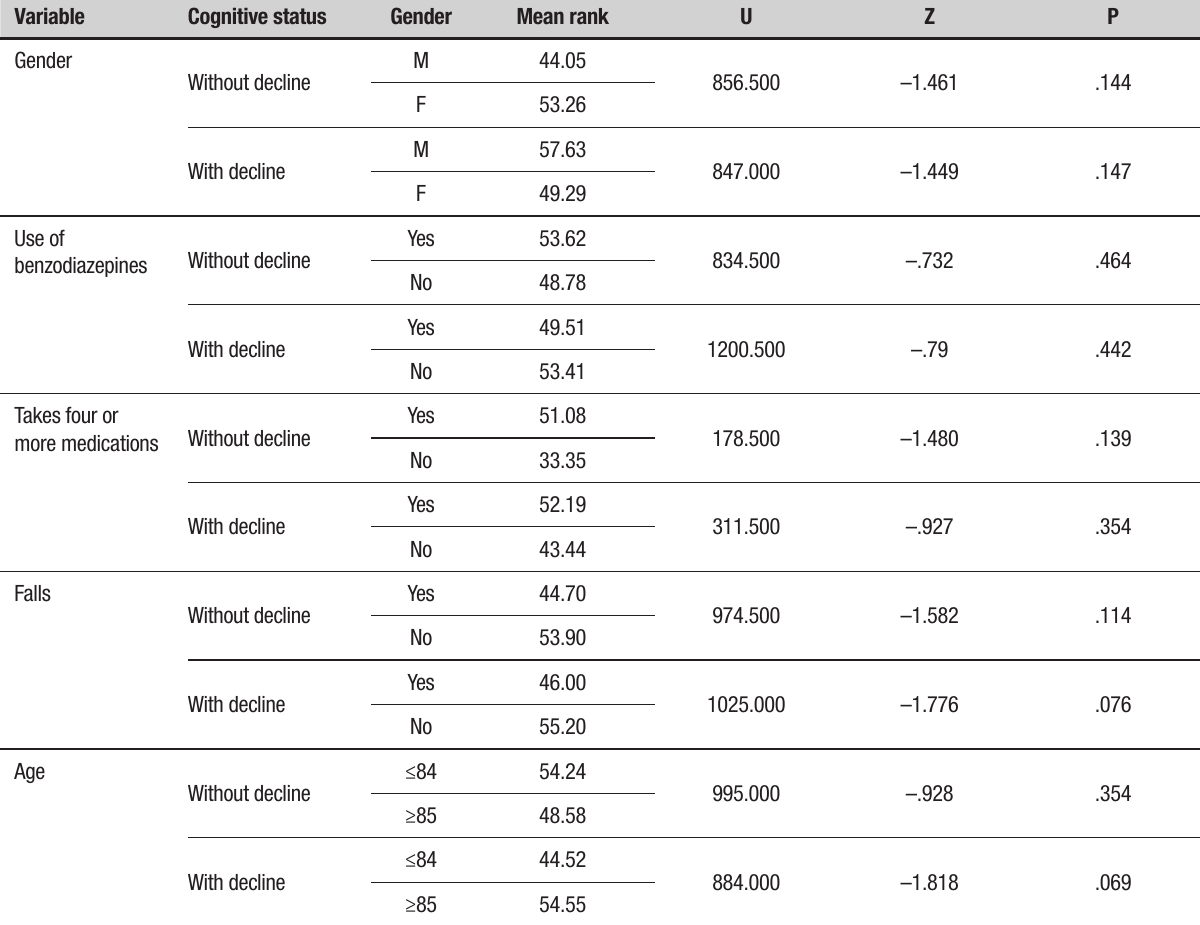
Table 2. Results of the application of the Mann-Whitney U-test regarding practices and behaviors of elderly with and without cognitive decline. Lisbon, Portugal, 2018